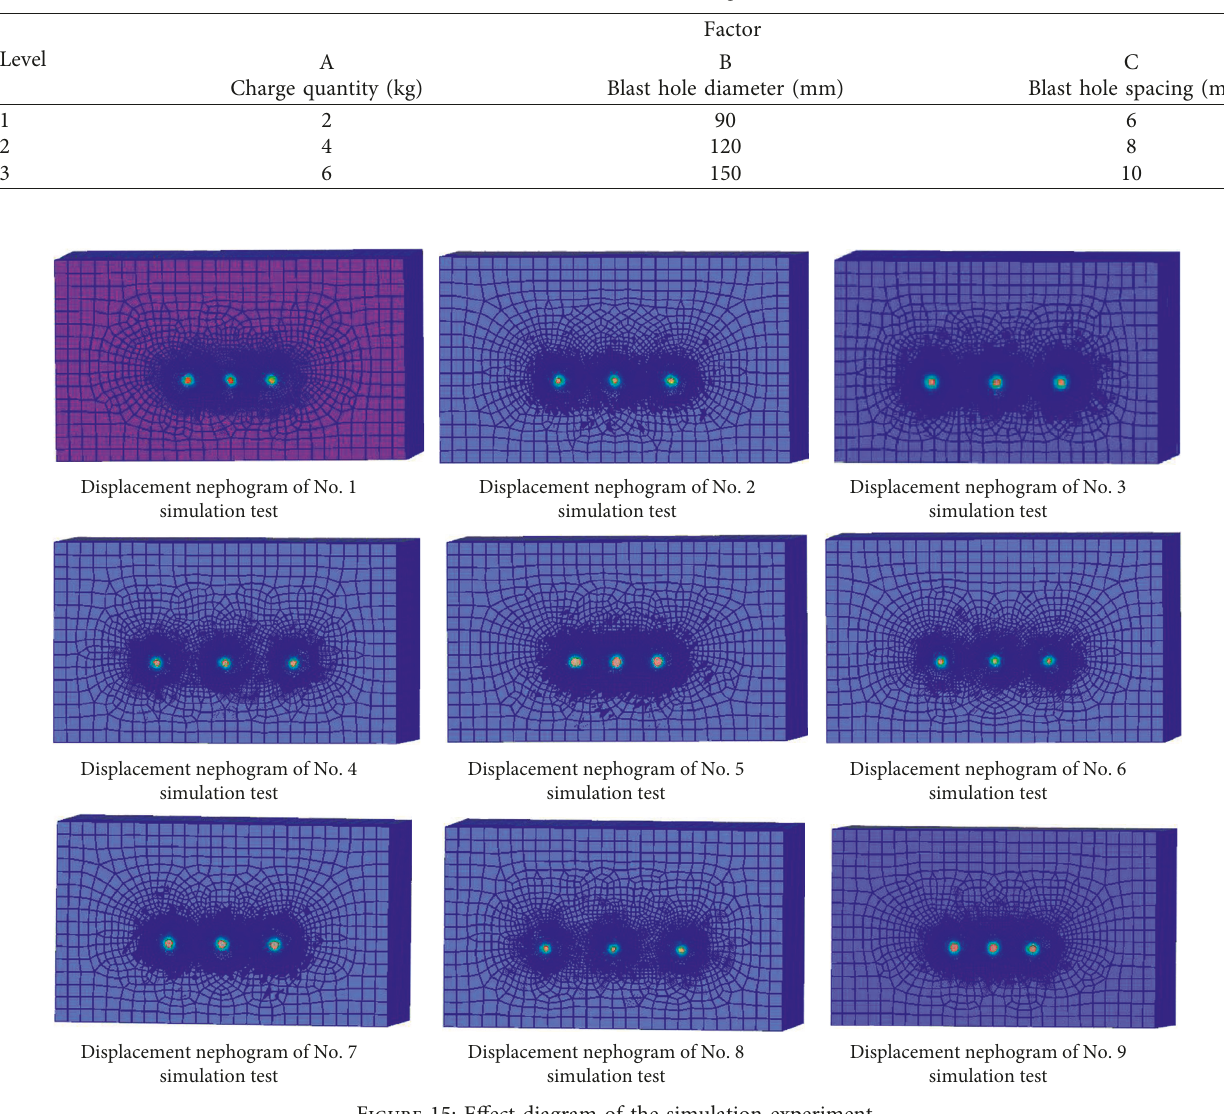
Table 2: Factor level of the orthogonal test.